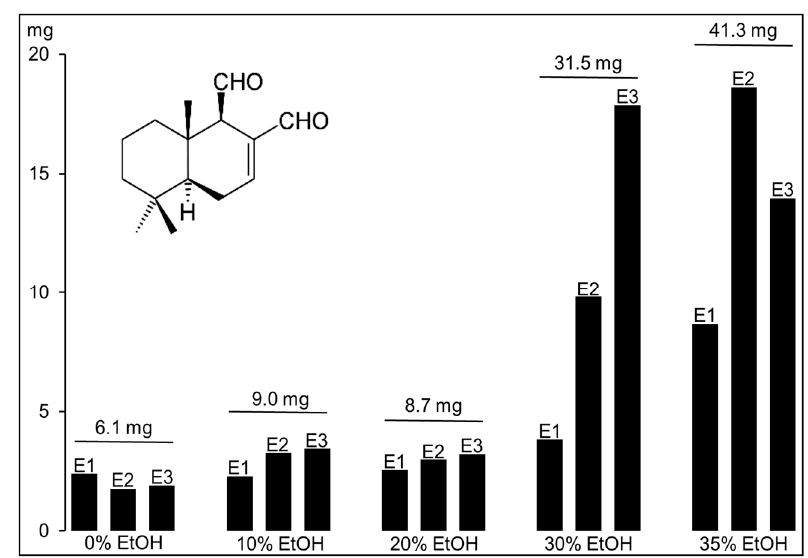
Figure 2. Amount of polygodial (mg) from the first (E1), second (E2), and third (E3) extracts obtained by PHWE of 15 g (each) Tasmannia lanceolata leaf. The total amount extracted (E1 + E2 + E3) from three consecutive PHWE is at the top of each extraction solution. Analysis was by MEKC, as described in the Materials and Methods Section and Figure 1.